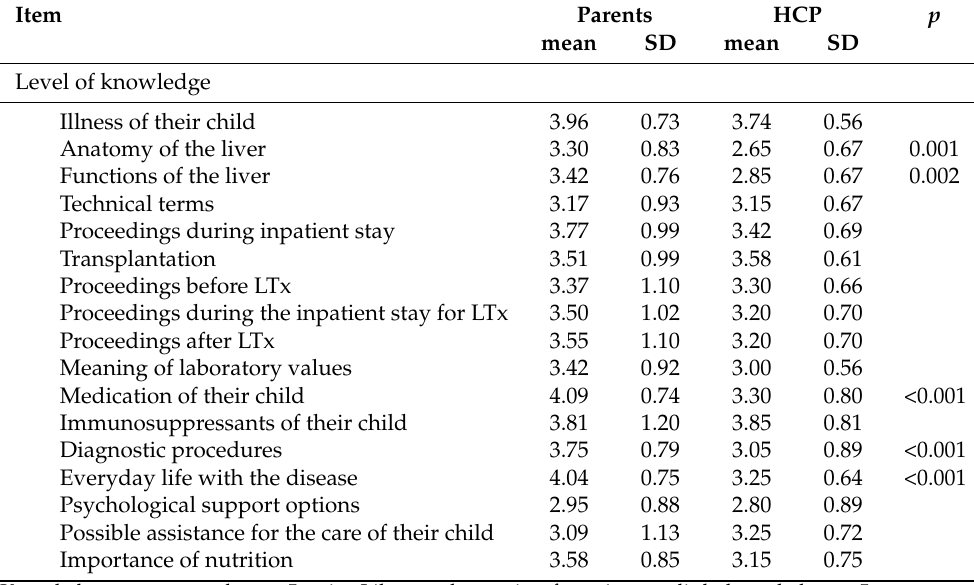
Table 3. Parental knowledge as assessed by parents and